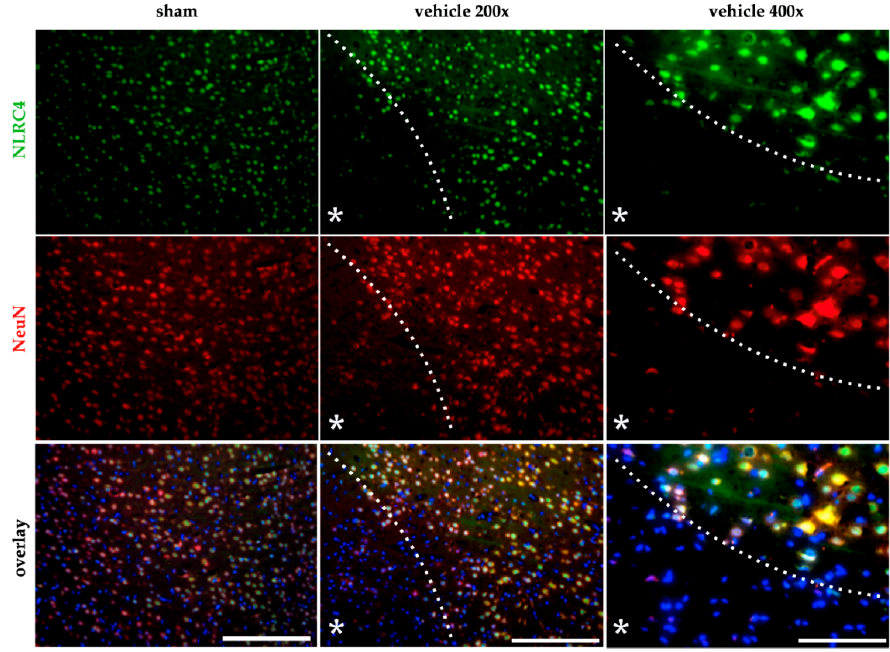
Figure 6. NLRC4 is mainly abundant in neurons after cerebral ischemia in rats. The co-localization of NLRC4 was evaluated by IF-co-staining with neurons (NeuN) in the sham and vehicle group (tMCAO + 24 h reperfusion). NLRC4 was mainly localized in NeuN + neurons in sham animals, as well as in the vehicle group after cerebral ischemia. White bars indicate a scale of 250 µ m (200 × magnification of sham and vehicle) or 100 µ m (400 × magnification). The dashed line delineates the transition zone of the peri-infarct area around the ischemic core (asterisk). NeuN–Fox-3, Rbfox3, or